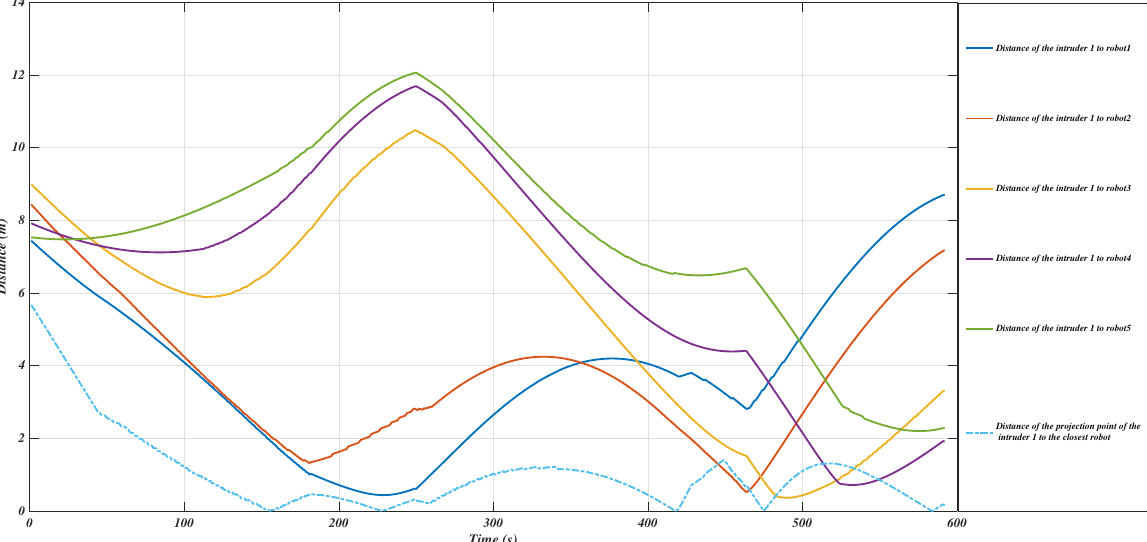
Figure 7. The evolution of the y -coordinates of the intruder1 and the USVs in segment S